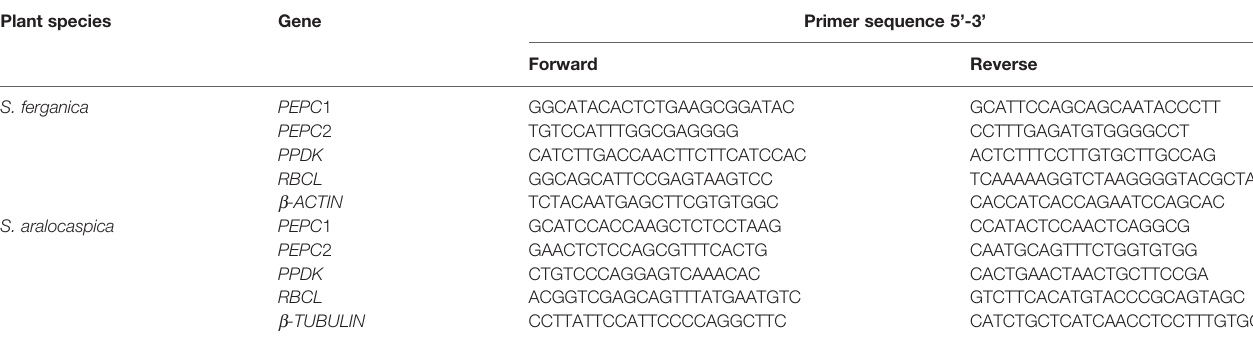
TABLE 2 | Primer sequences used in the present